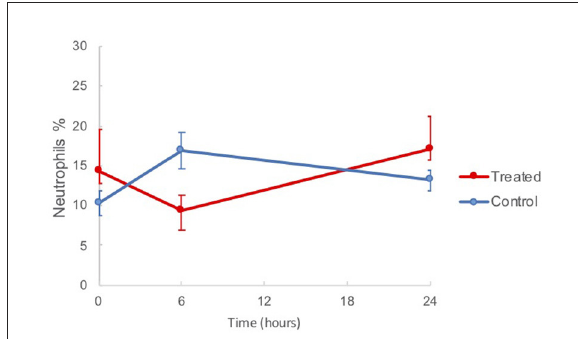
FIGURE3 Mean BAL neutrophil percentages in horses from baseline ( t = 0h) to 24h post nebulization with either control substance or G-CAPE (treated).